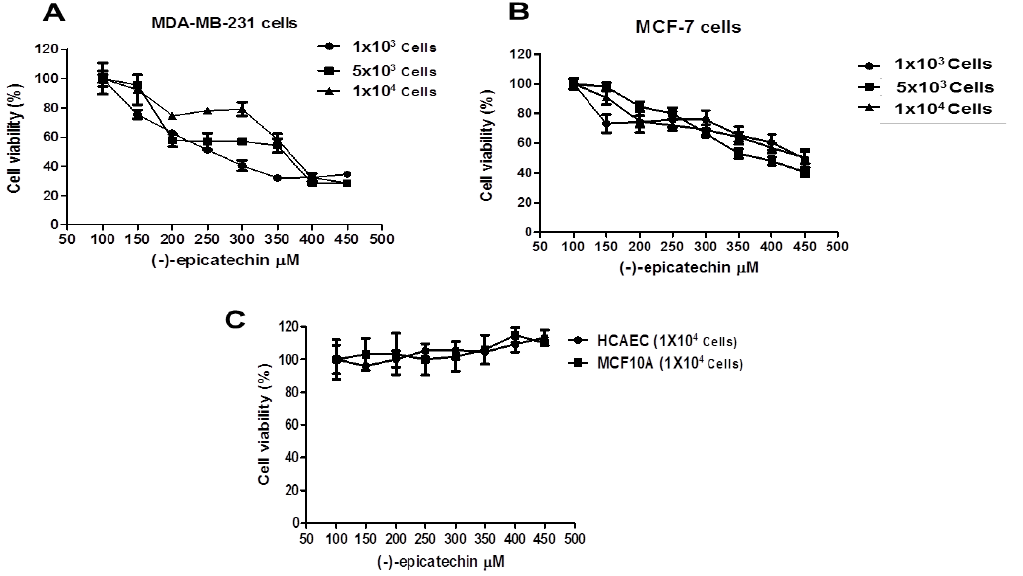
Figure 2. Effects of (−)-epicatechin on cell viability in breast cancer cells. ( A ) MDA-MB-231, ( B ) MCF-7 (1 × 10 3 , 5 × 10 3 or 1 × 10 4 cells), and ( C ) human coronary artery endothelial cells (HCAEC) and MCF10A (1 × 10 4 cells) were grown onto 96-well plates and allowed to grow for 24 h. Then, the cells were treated with (−)-epicatechin (100–450 μM) for 72 h. The number of viable cells was determined by [3-(4,5-Dimethyl-2-thiazolyl)-2,5-diphenyl-2H-tetrazolium bromide] (MTT) assay. Each data point was performed in sextuplicate in three different experiments, and the results were reported as the mean absorption ± SD.